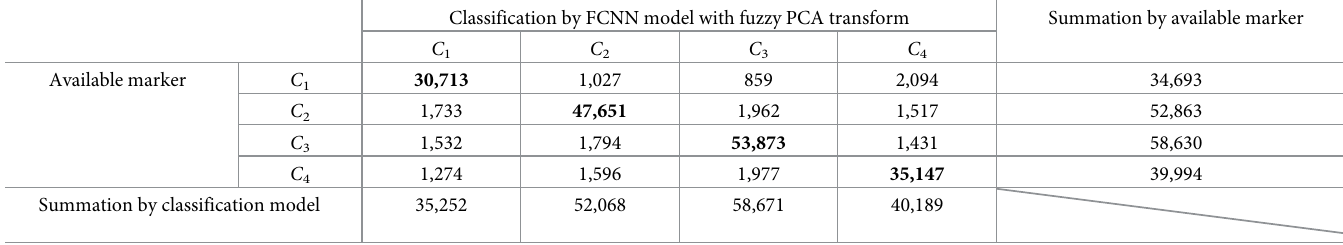
Table 3. The discriminant confusion matrix conducted based on the optimal FCNN classification model trained with the fuzzy–PCA–transformed 5 PCs. Classification by FCNN model with fuzzy PCA